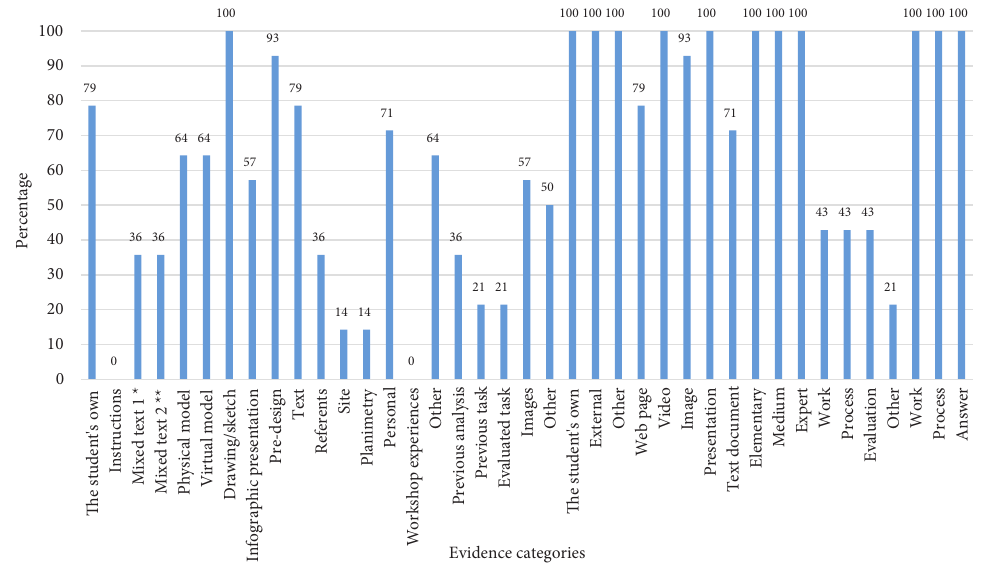
Figure 1. Capacity of each category to refer to the biggest number of architectonic learning components (source: Authors,